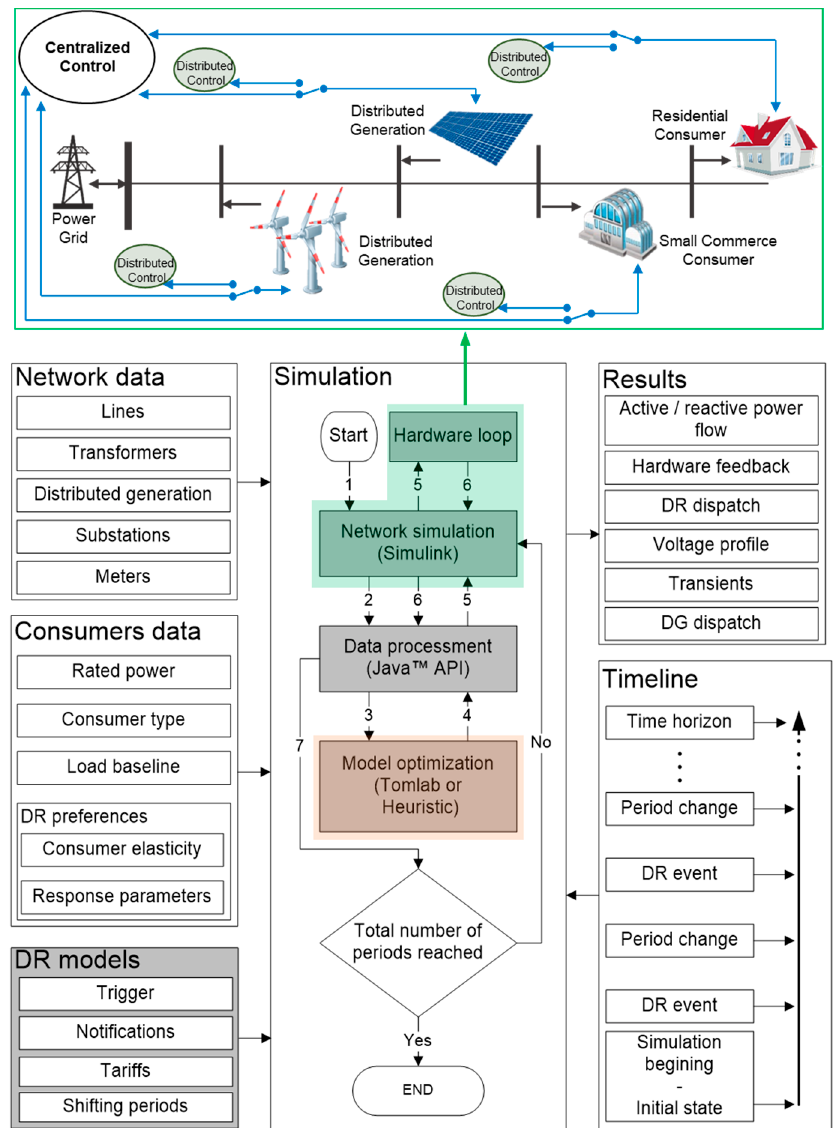
Figure 1. Proposed microgrid configuration for the simulation platform for the integration of demand response (SPIDER) simulation platform implementation.